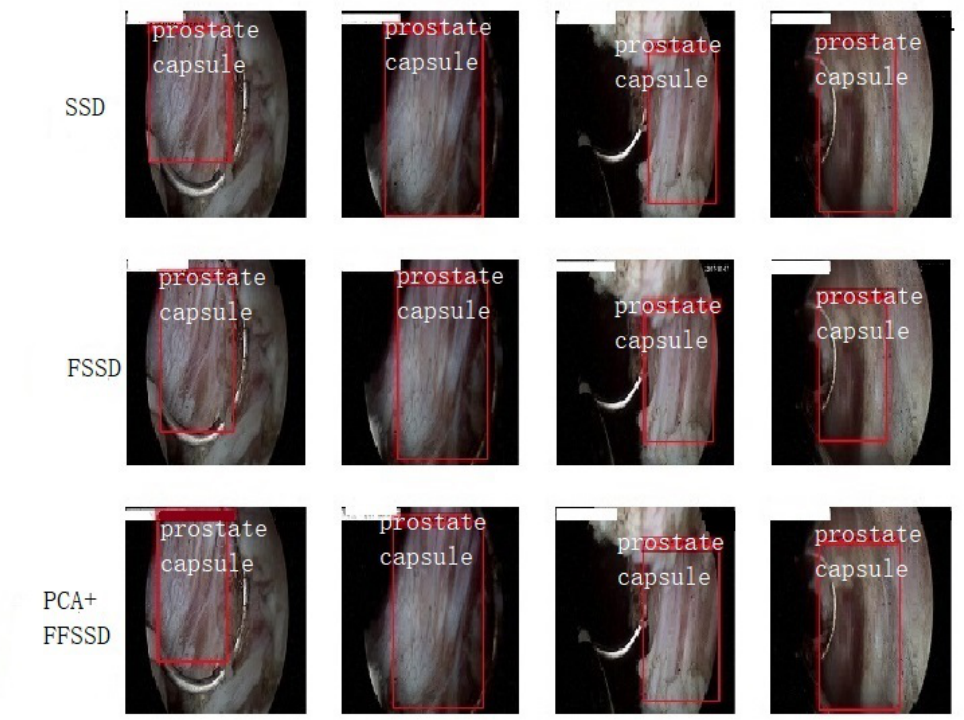
Figure 12. Detection result comparison for SSD, FSSD, and